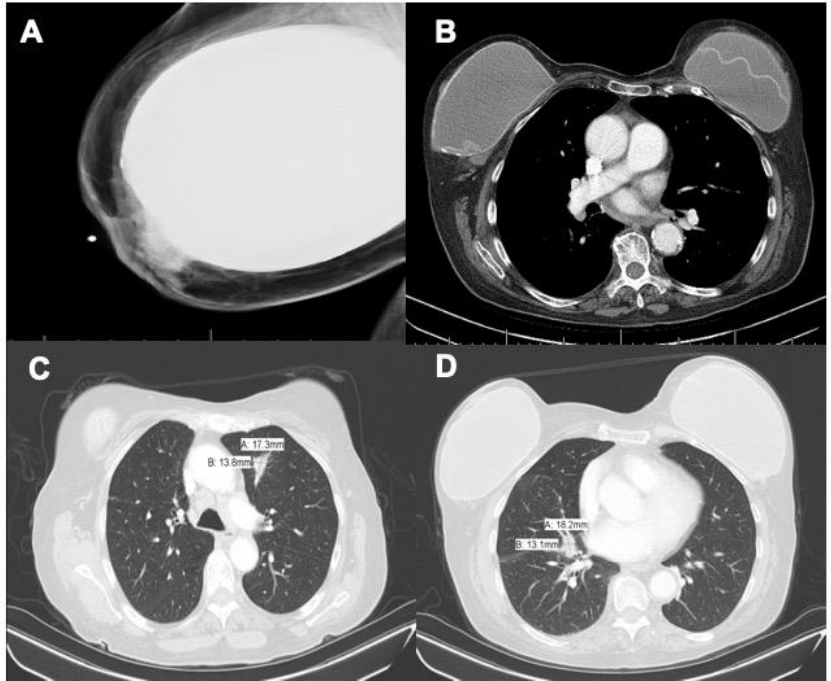
Figure 1. ( A ) Mammogram demonstrating extracapsular rupture of the right breast, ( B ) mediastinal window chest CT demonstrating Linguine Sign of the left breast implant, ( C ) chest CT showing an 18 mm × 14 mm nodule in the right middle lobe causing concern for malignancy, and ( D ) the same image showing a 17 mm × 14 mm spiculated left lung nodule with concern for breast involvement.